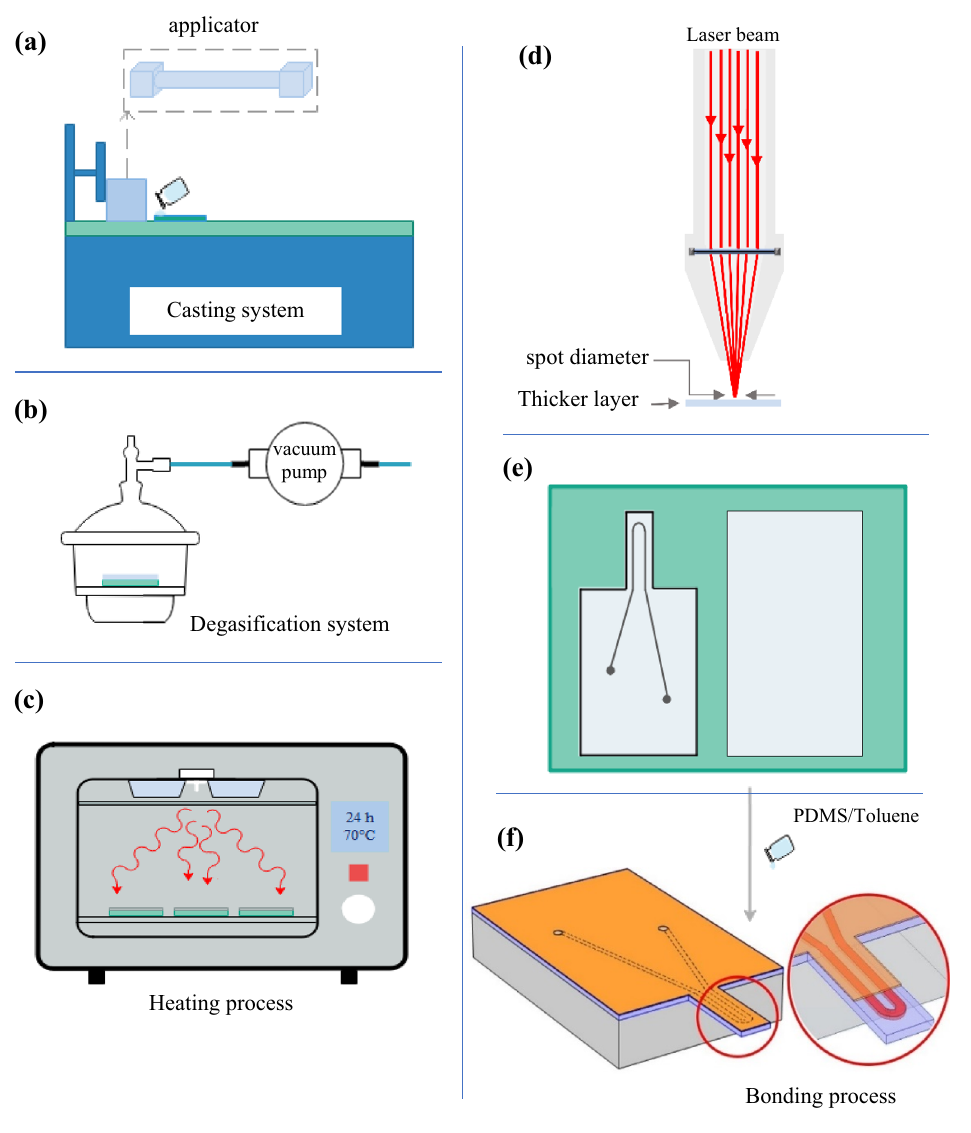
Figure 2. The fabrication process of the microchip: ( a ) smooth layer casting process, ( b ) degasification step, ( c ) heating process, ( d )